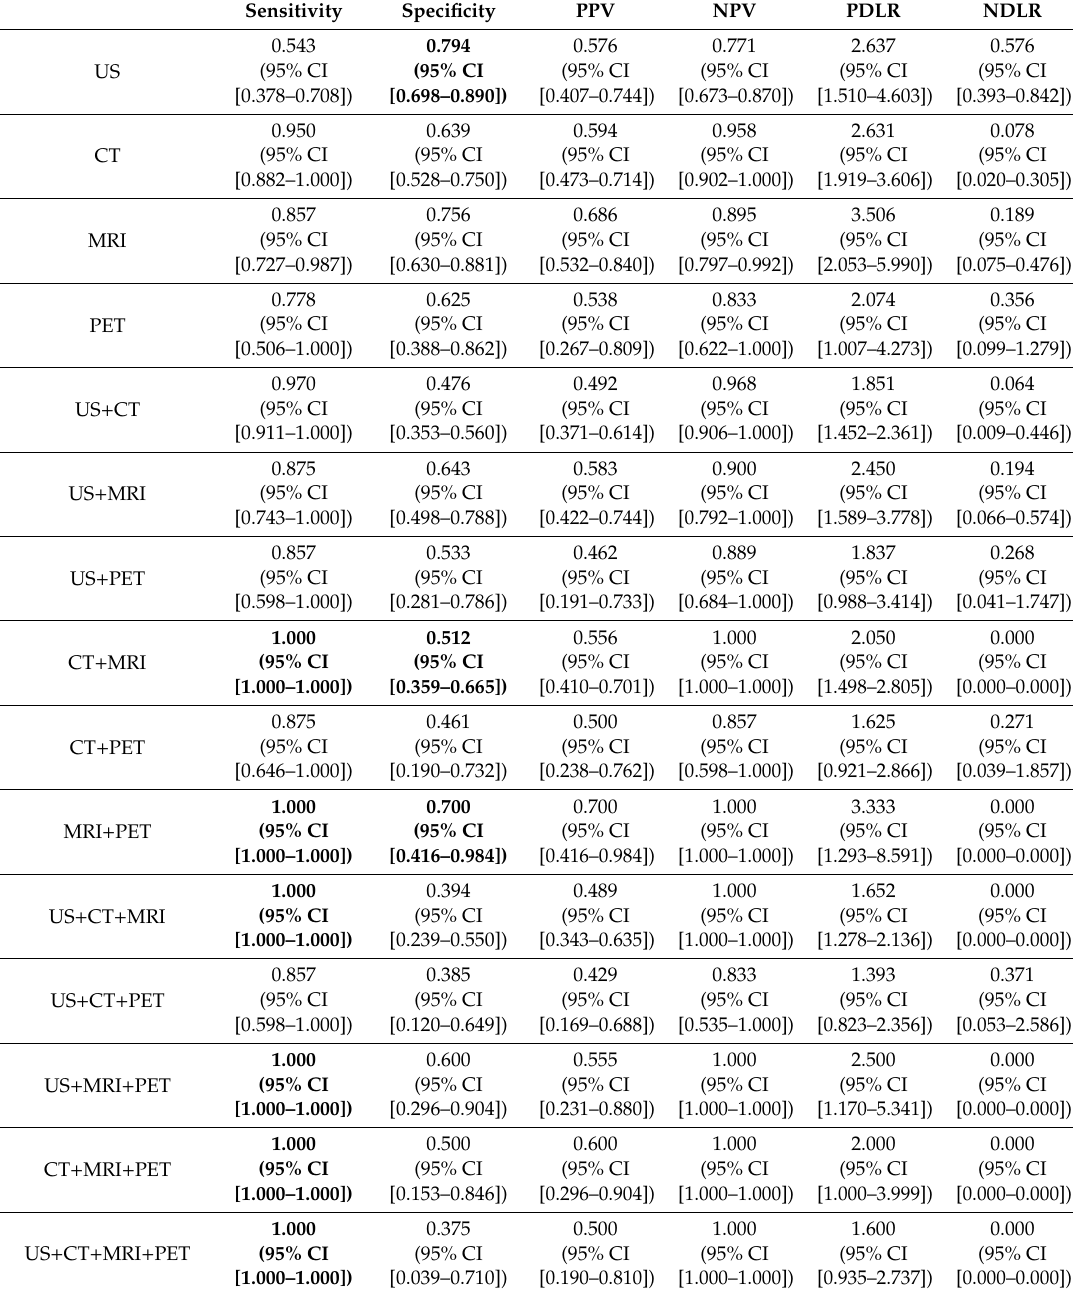
Table 5. Comprehensive overview including all imaging modalities. Key results relevant for our conclusions are highlighted in